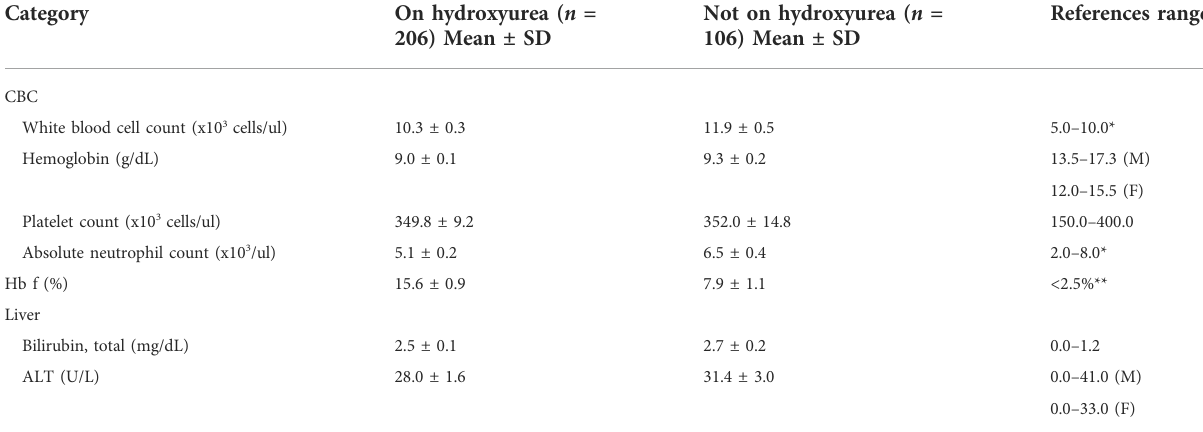
TABLE 4 Provider-reported laboratory values by hydroxyurea use ( n = 312) a